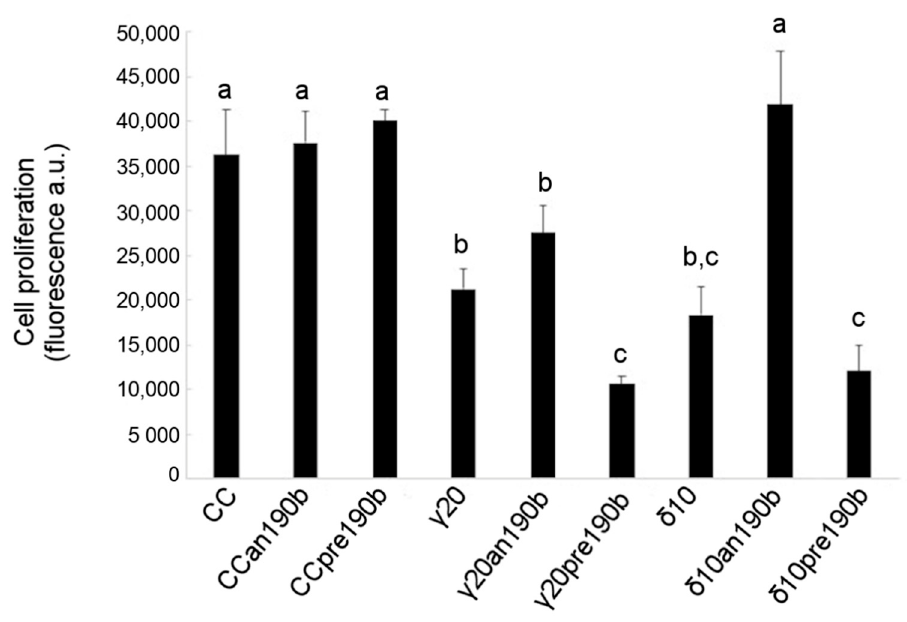
Figure 4. Effects of γ T3 (20 µg/mL for 24 h) and δ T3 (10 µg/mL for 24 h) on the proliferation of HeLa cells transfected with pre-miR-190b (pre190b) and anti-miR-190b (an190b). Results are reported as the mean ± SD of data obtained from 5 independent experiments and expressed as arbitrary fluorescence values normalized per 10,000 cells. Bars show a log 2 fold-change (treated vs. control, CC). Data were analyzed by one-way ANOVA with repeated measures, followed by Tukey’s test. Different letters (a, b, c) indicate significant differences ( p < 0.05).